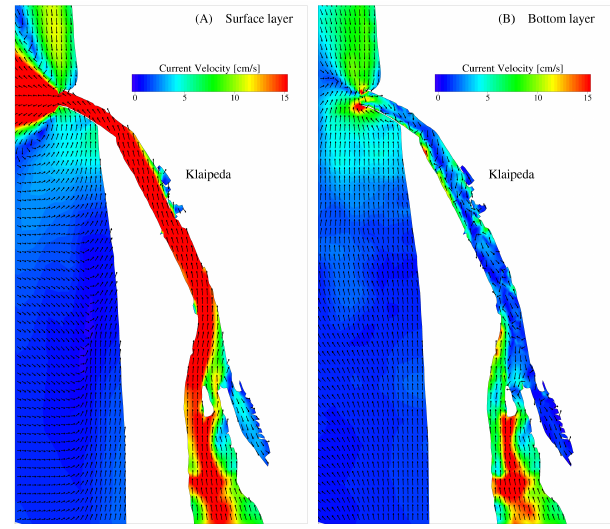
Fig. 6. Maps of yearly averaged modelled surface (A) and bottom (B) currents in the Klaip˙eda